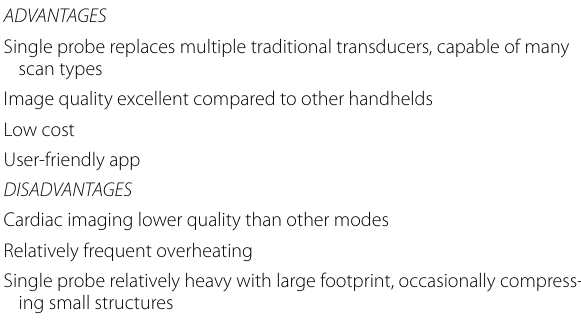
Table 1 Advantages and disadvantages of the butterfly iQ